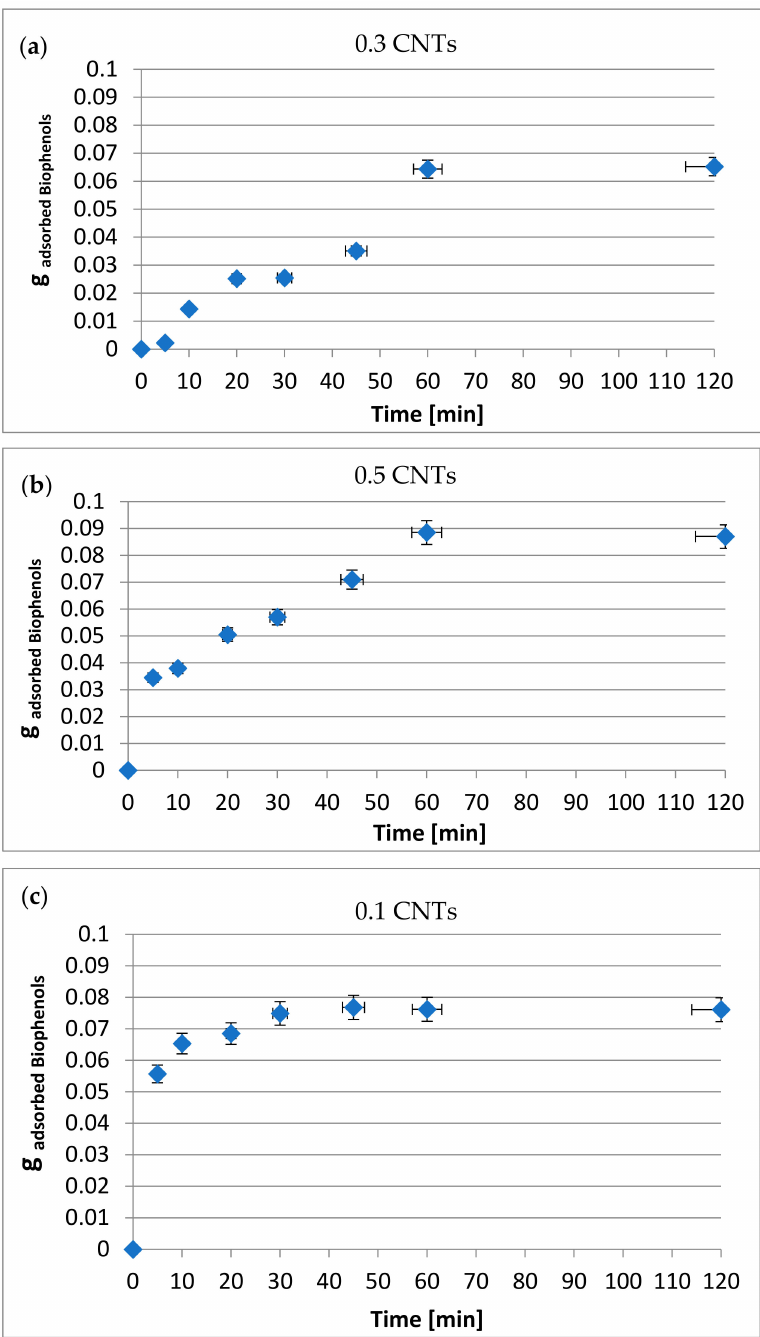
Figure 4. Quantity of adsorbed biophenols as a function of time in systems with ( a ) 0.3, ( b ) 0.5, ( c ) 1.0 g of nanotubes in 20 mL of